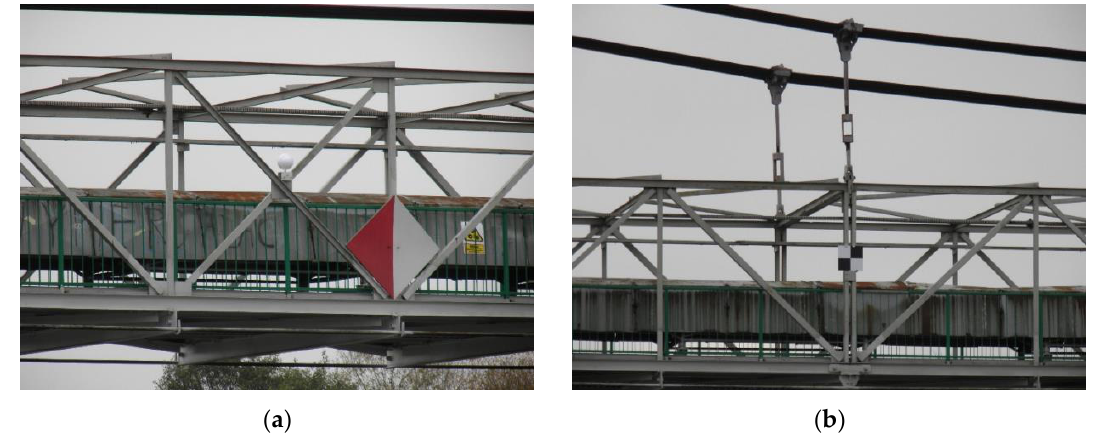
Figure 7. The supplementary measuring components fixed on the structure: ( a ) sphere, ( b ) measuring square shield (checker).